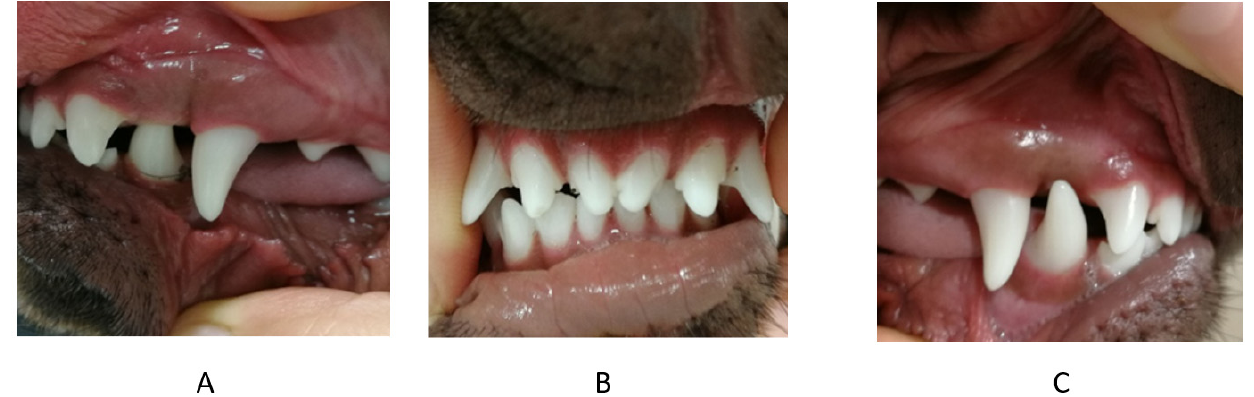
Figure 5. Second case. Intraoral photographs in full occlusion before treatment—press of the mandible against the maxilla, the recess behind the maxillary canine and the visible asymmetry of the arches with a disturbed plane. ( A ) left side, ( B ) en face, ( C ) right side.